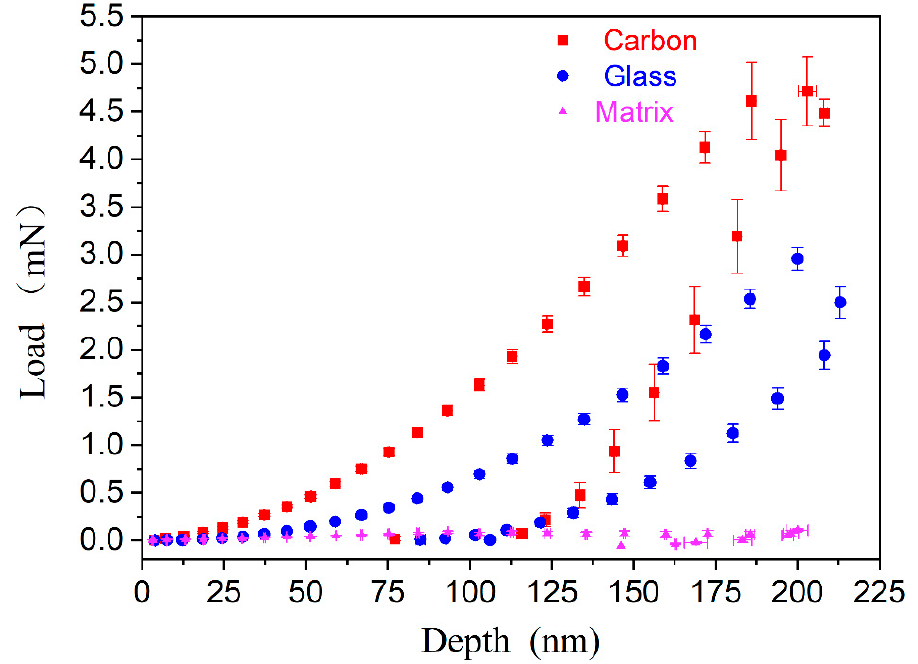
Figure 2. Load–depth curves for the three different